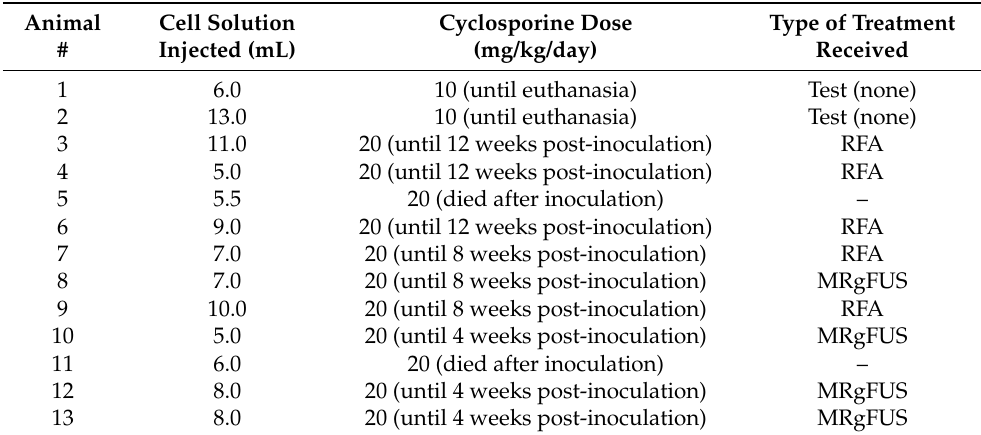
Figure 1. Setup environment for cell inoculation. Fluoroscopy allowed for the visualization of the heart and the ribs, guiding the procedure. Inoculations were performed on the right side in the intercostal spaces. Table 1. Summary for volumes of the MSTO-211H solution injected, dose of cyclosporine adminis- tered, and type of treatment received by each pig.